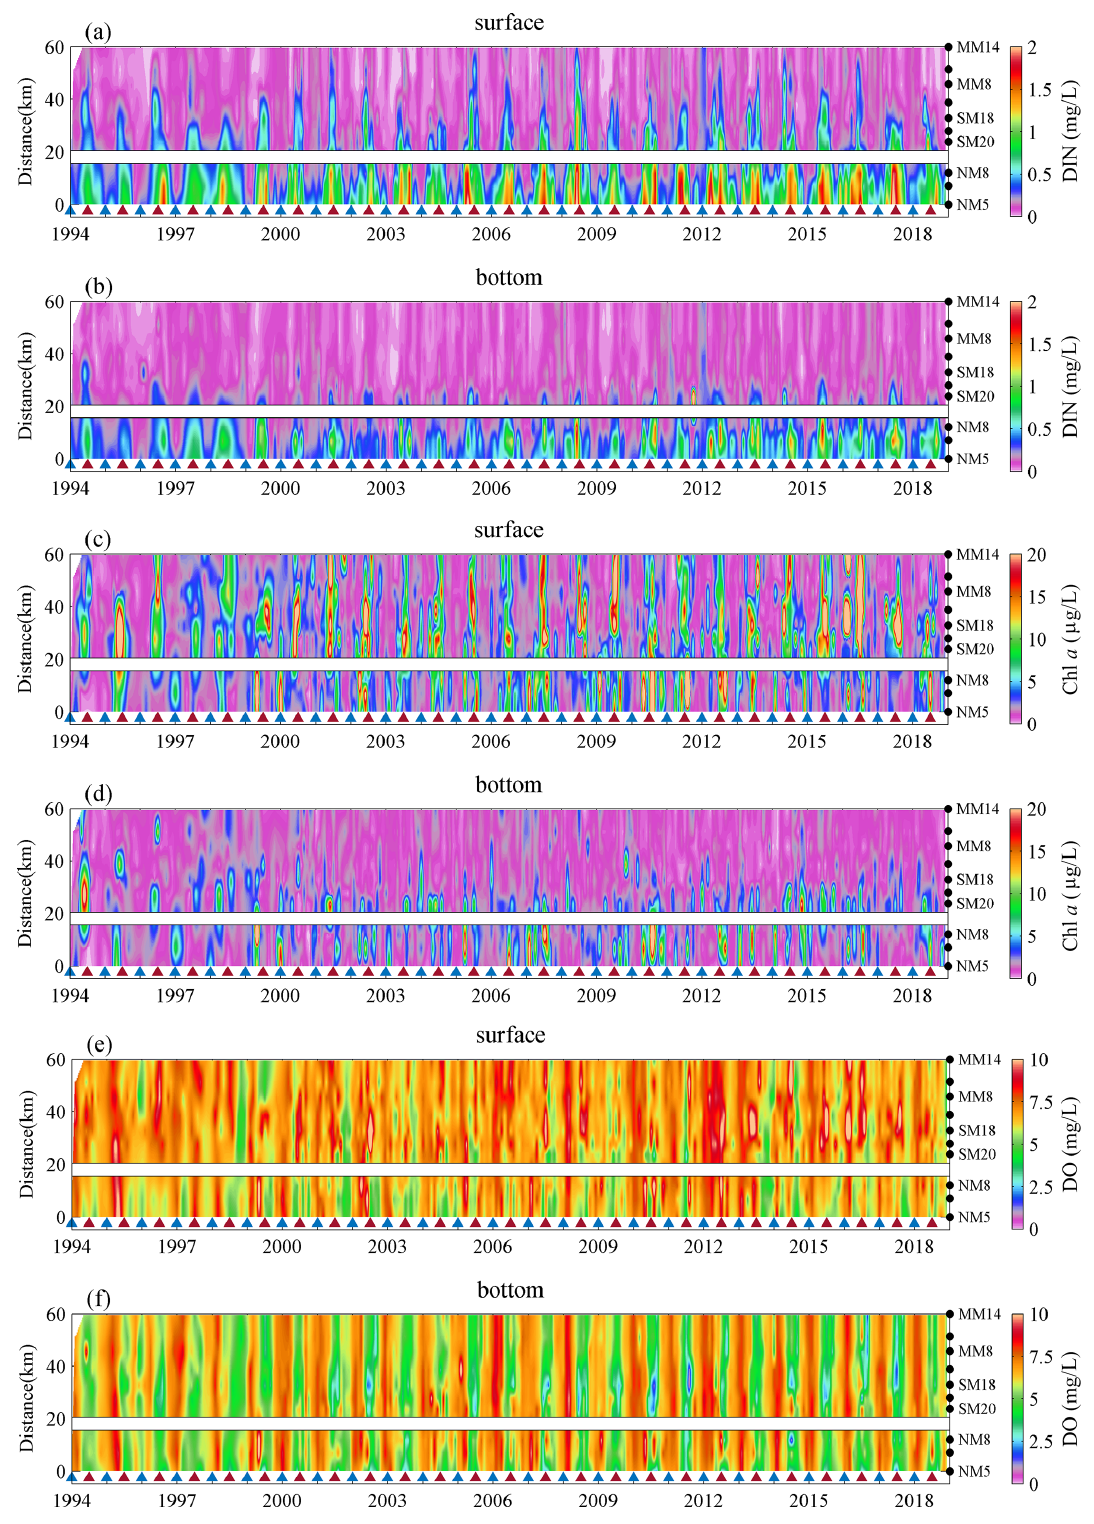
Figure 3. Same as Fig. 2 but for concentrations of DIN (a, b) , Chl a (c, d) , and DO (e, f)